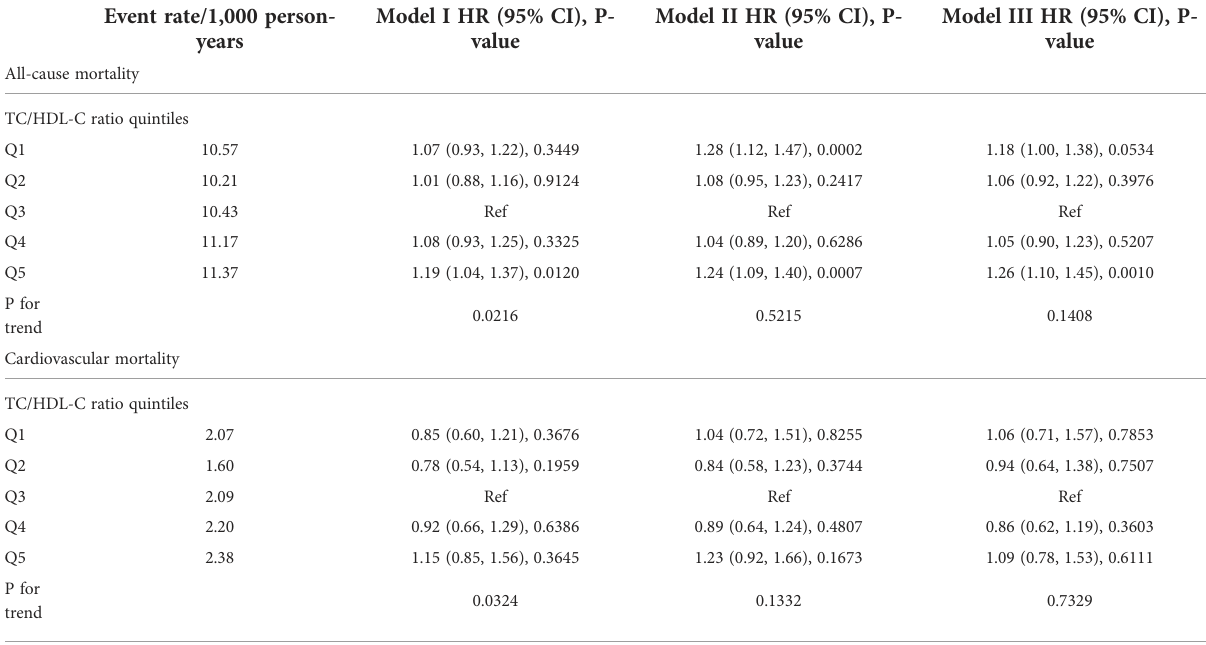
TABLE 2 Multivariate Cox regression analysis of the TC/HDL-C ratio with all-cause mortality and cardiovascular mortality. Event rate/1,000 person-